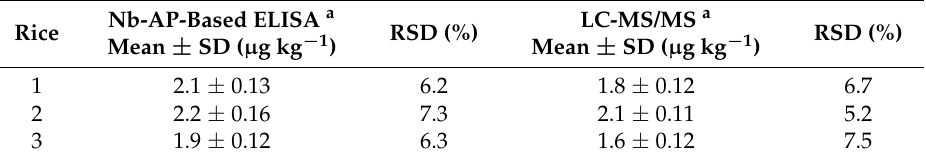
Table 4. Detection of OTA in rice samples by the Nb-AP-based one-step ELISA and LC-MS/MS.